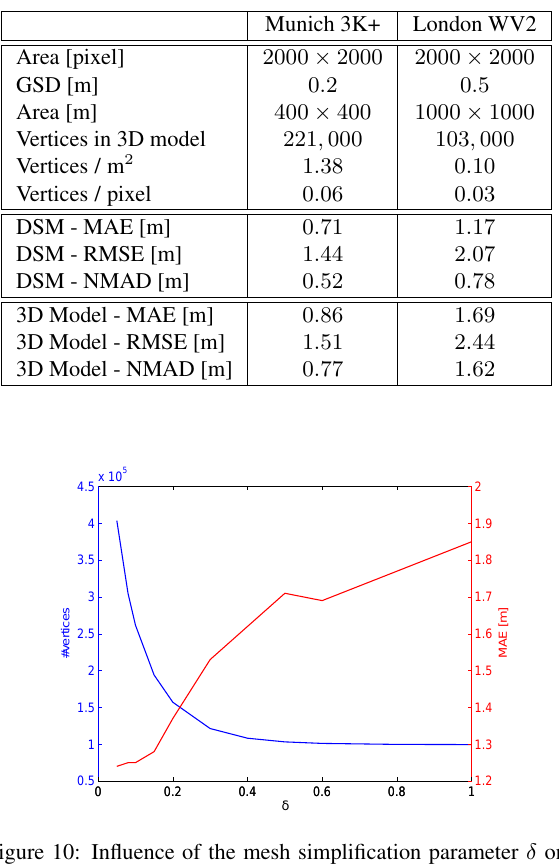
Table 1: Properties of the two data sets and accuracy of the result- ing DSMs and 3D models - Mean Absolute Error (MAE), Root Mean Square Error (RMSE), Normalized Median Absolute De-